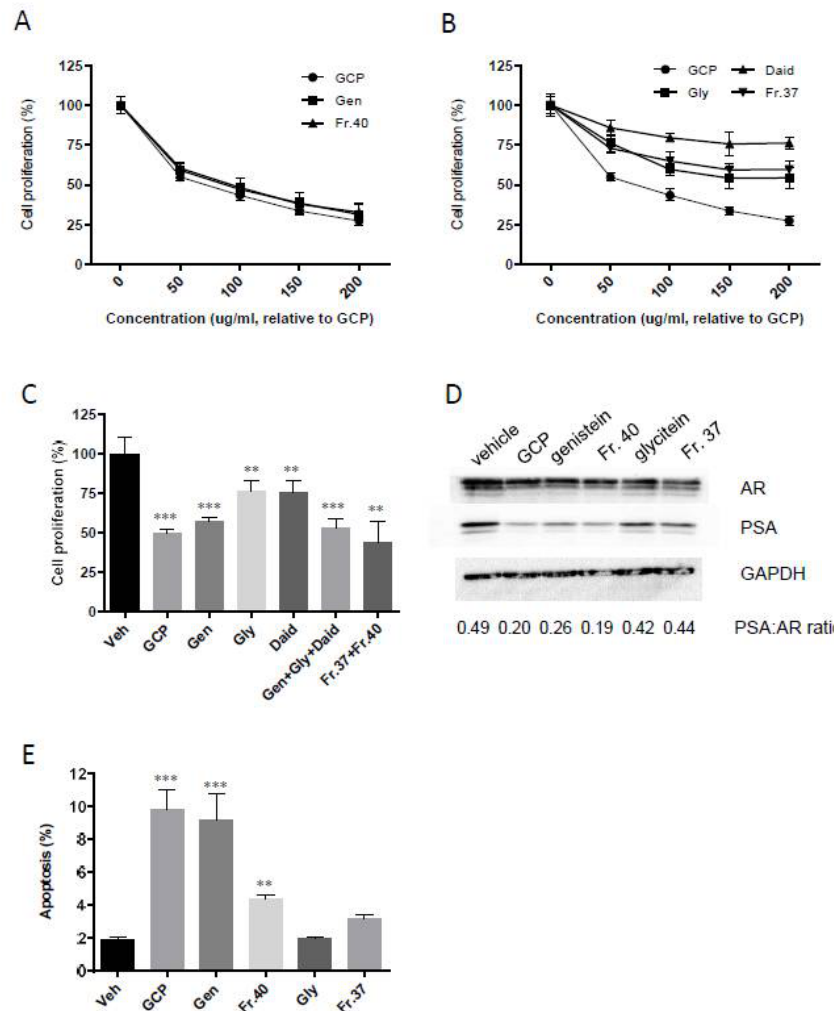
Figure 5. GCP and genistein are equally effective in terms of their ability to inhibit prostate cancer cell proliferation, decrease androgen receptor expression, decrease PSA levels, and promote cell apoptosis. All of the biomolecules (GCP, genistein, daidzein, glycitein) and fractions (fractions 37 and 40) being tested caused a dose-dependent reduction is LNCaP cell proliferation ( A , B ). Our data further confirm that GCP, genistein, and fraction 40 have similar levels of anti-proliferative activity ( A ). Combining genistein, glycitein, and daidzein, or combining fractions 37 and 40, did not further decrease cell proliferation compared to treatment with GCP or genistein as single agents ( C ). GCP, genistein, and fraction 40 decreased PSA activity to a similar degree (~2.5-fold decrease ( D ). GCP, genistein, and fraction 40 also caused a significant increase in apoptosis ( E ), however, while GCP and genistein caused a ~5-fold increase in apoptosis, fraction 40 mediated only a ~2-fold increase. Note that, to reflect their relative concentration in GCP (100 ug / mL), hence the x -axis is labelled